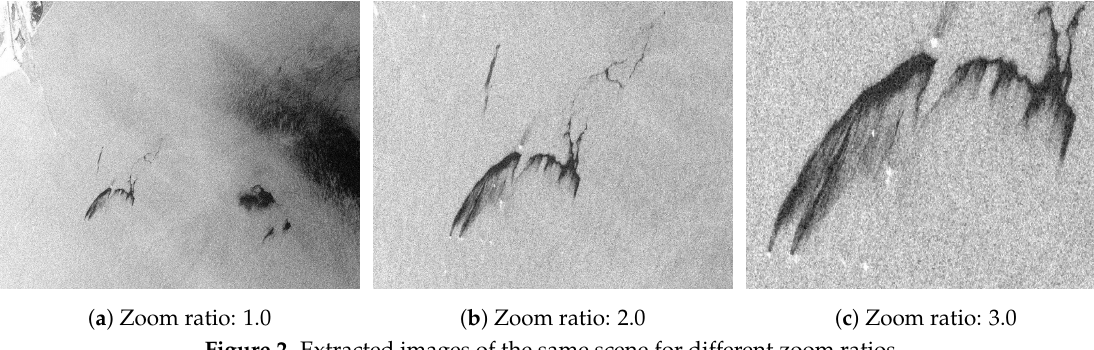
Figure 2. Extracted images of the same scene for different zoom ratios.